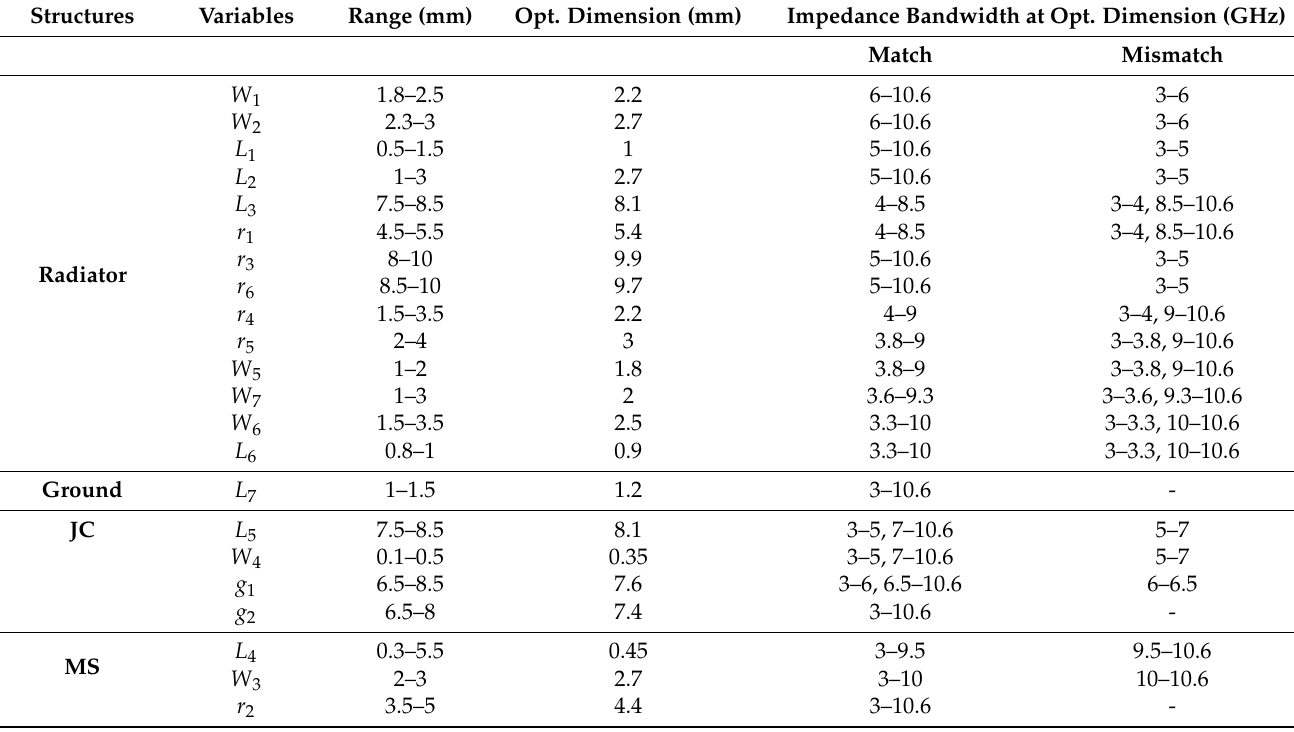
Table 1. Optimization of the proposed